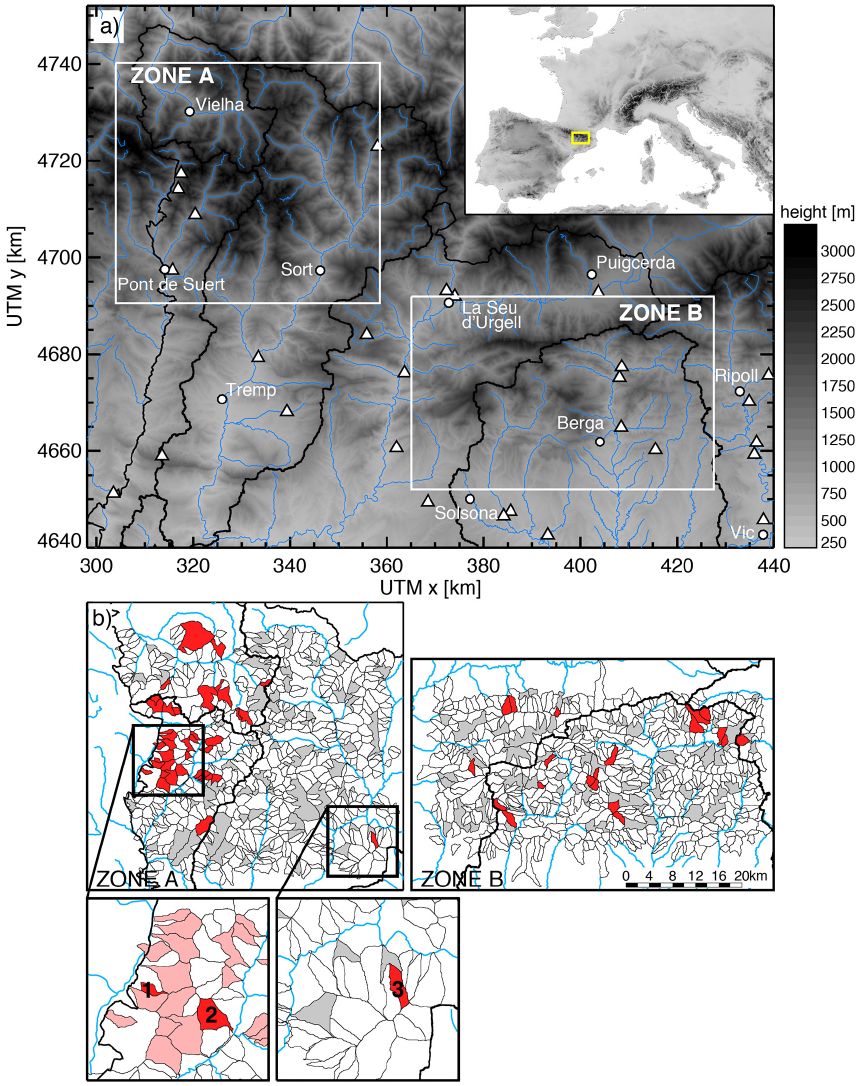
Figure 1. Study area: (a) the two white rectangles in the main panel show the two subdomains where the EWS has been implemented (zones A and B). The circles indicate the location of the main municipalities, and the triangles show the location of the available rain gauges. (b) Subdivision of zones A and B in subbasins for the implementation of the system. The first and second order subbasins are indicated in white and grey, respectively. Analysis of aerial photos detected traces of DFs in the red-shaded subbasins. In the two bottom left sub-panels, the numbers correspond to subbasins (1) Rebaixader (0.7km 2 ), (2) Erill (3.1km 2 ) and (3) Port Ainé (1.9km 2